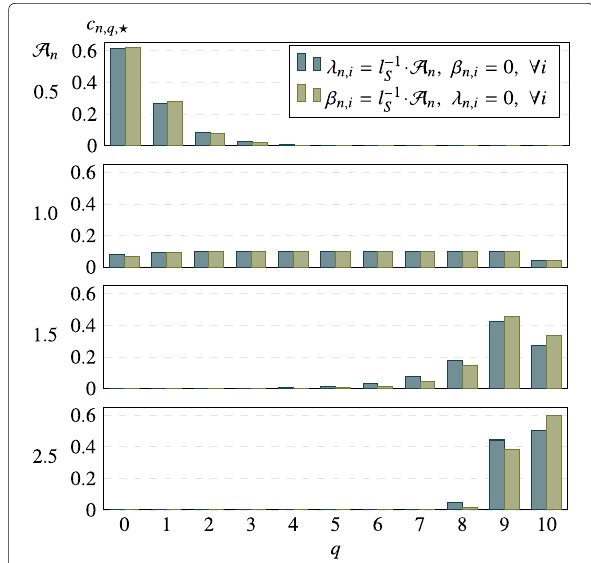
Fig. 8 Distribution of queue levels for K = 10, l S = 5 and a single transmission